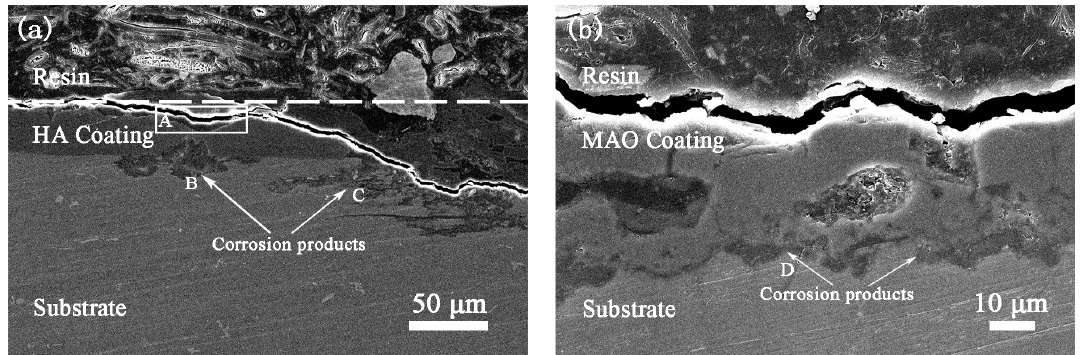
Figure 9. Cross-section SEM micrographs of the HA- ( a ) and the MAO-treated ( b ) 7050 Al alloy after a neutral salt spray test in 5 wt % NaCl solution for 1500 h. neutral salt spray test in 5 wt % NaCl solution for 1500